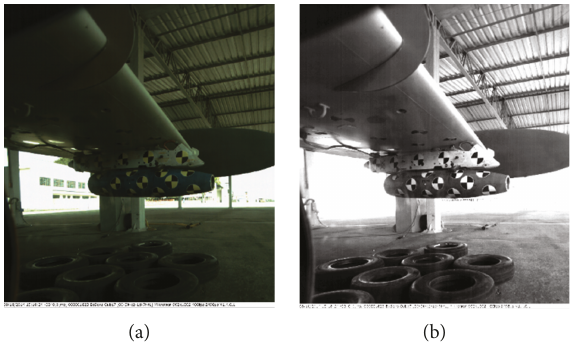
Figure 25: (a) Original image and (b) image after histogram